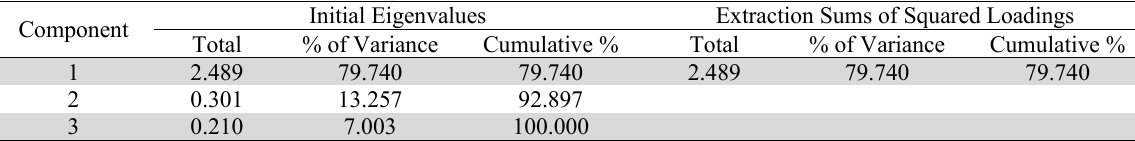
The factor transformation matrix of the dependent variable